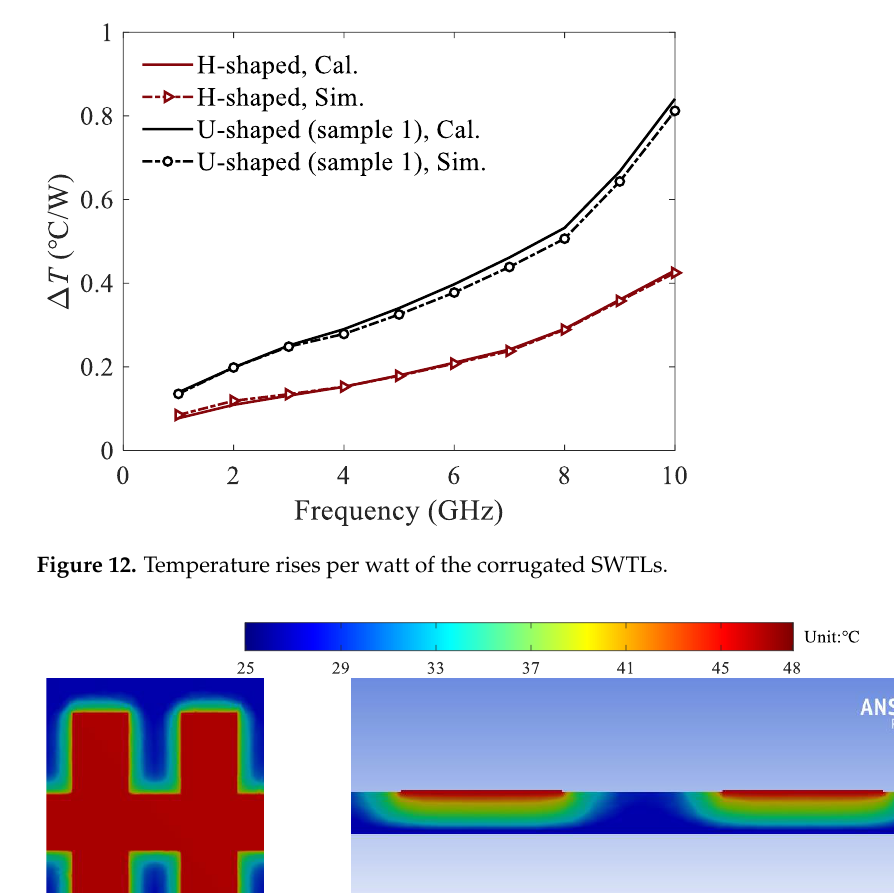
Figure 11. Attenuation constants of the corrugated SWTLs: ( a ) conductor attenuation; ( b ) dielectric attenuation.